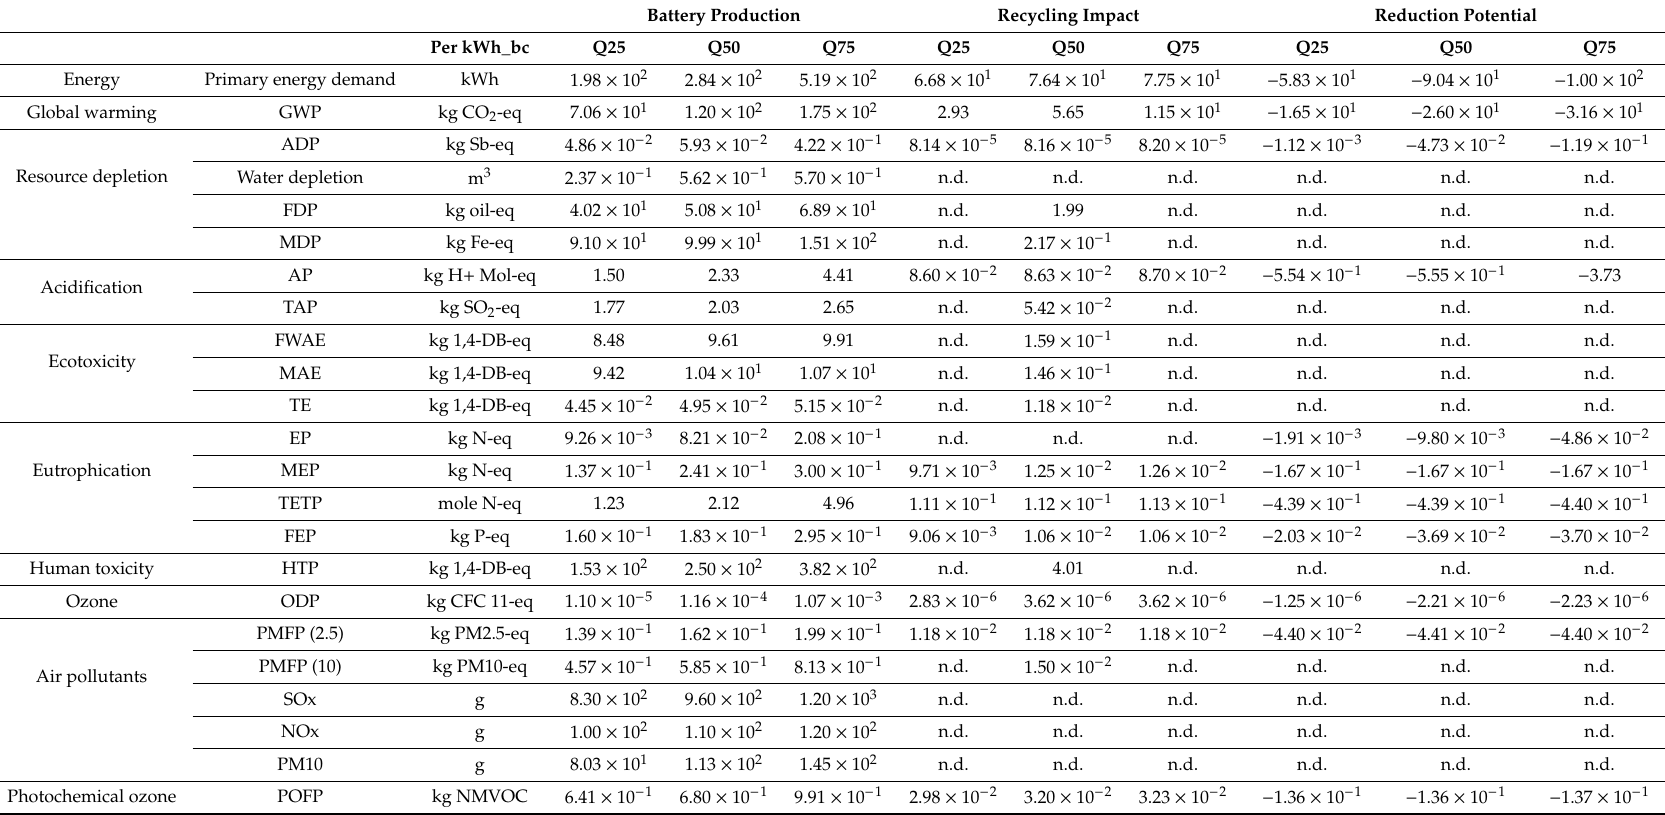
Table A2. Numerical results for various impact categories in LCAs (results based on 25%-quantile, median and